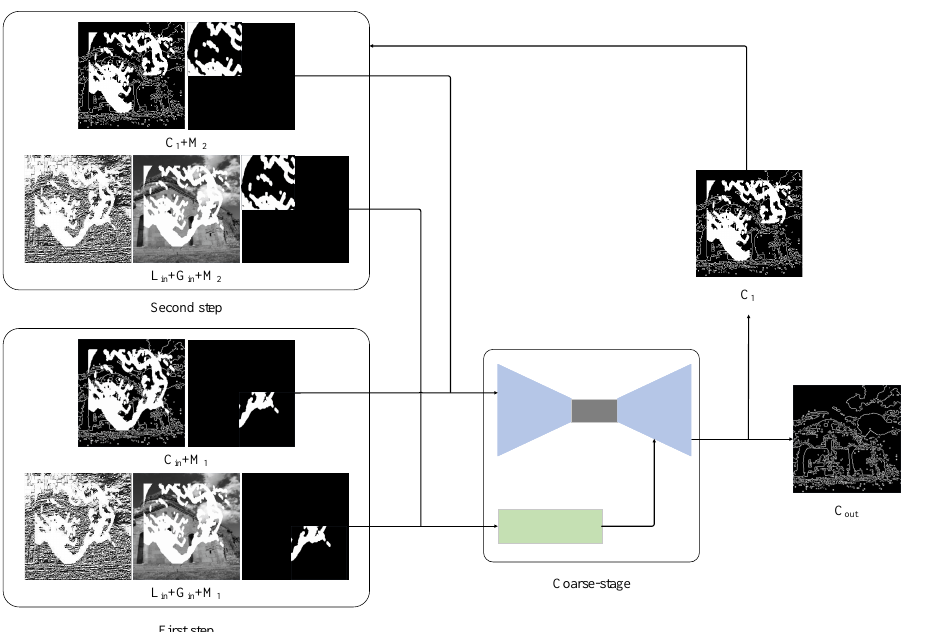
Figure 2. Multi-step structure model flowchart. The rough inpainting stage prioritizes structural reconstruction, and therefore, gray-scale images are used as input. The occlusion area is restored in four steps, with the inpainting order determined by priority calculation. The inpainting process begins with the lower right corner area, which has the highest priority, followed by the upper left corner area with the second highest priority. The final two steps follow a similar pattern. The result in the rough inpainting stage is represented as C out .